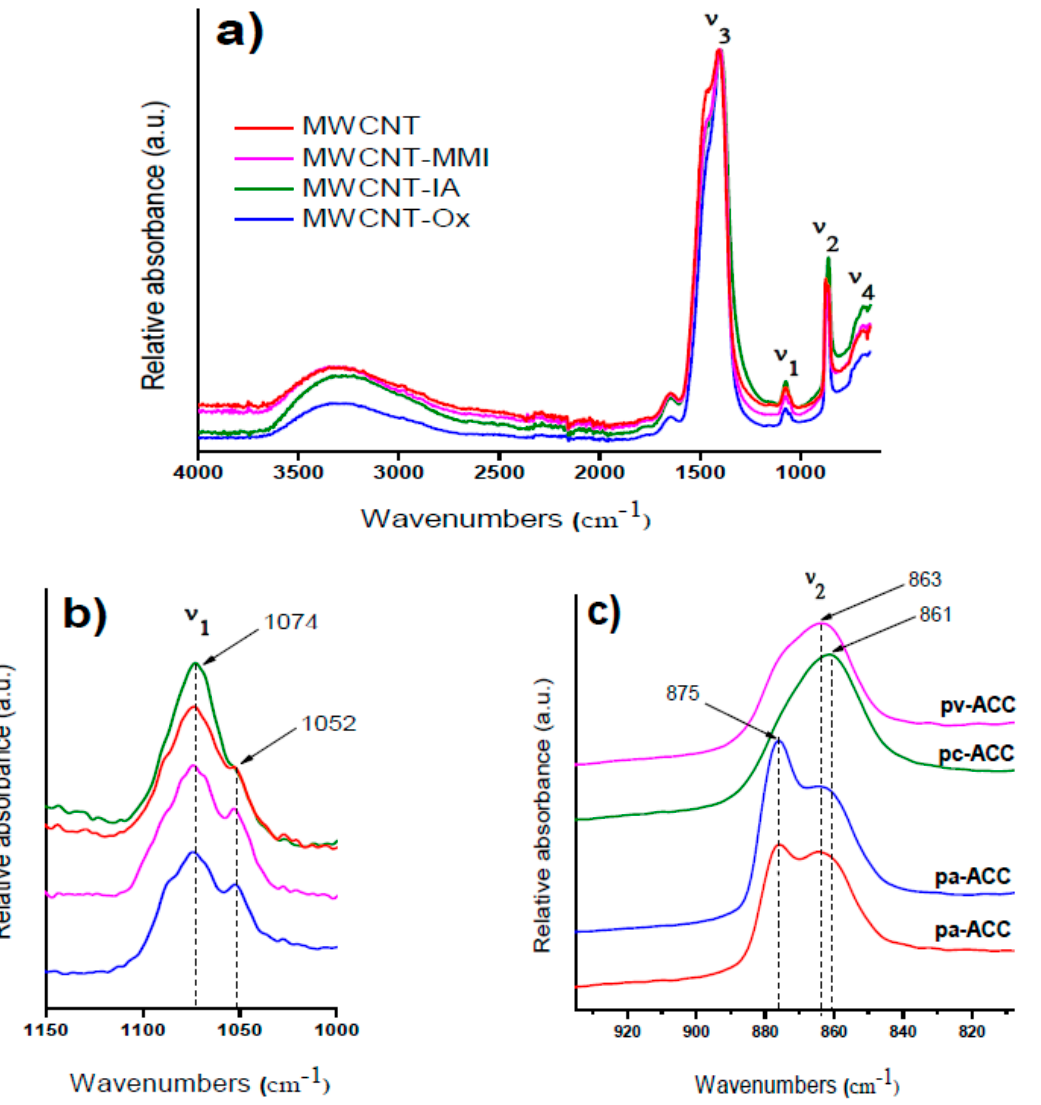
Figure 4. FTIR spectra of amorphous calcium carbonate (ACC) proto-structures obtained in the presence of MWCNT additives: ( a ) full spectra with ν 1, ν 2, ν 3, and ν 4 bands; ( b ) zoomed-in view for the ν 1 band and ( c ) zoomed-in view for the ν 2 band.